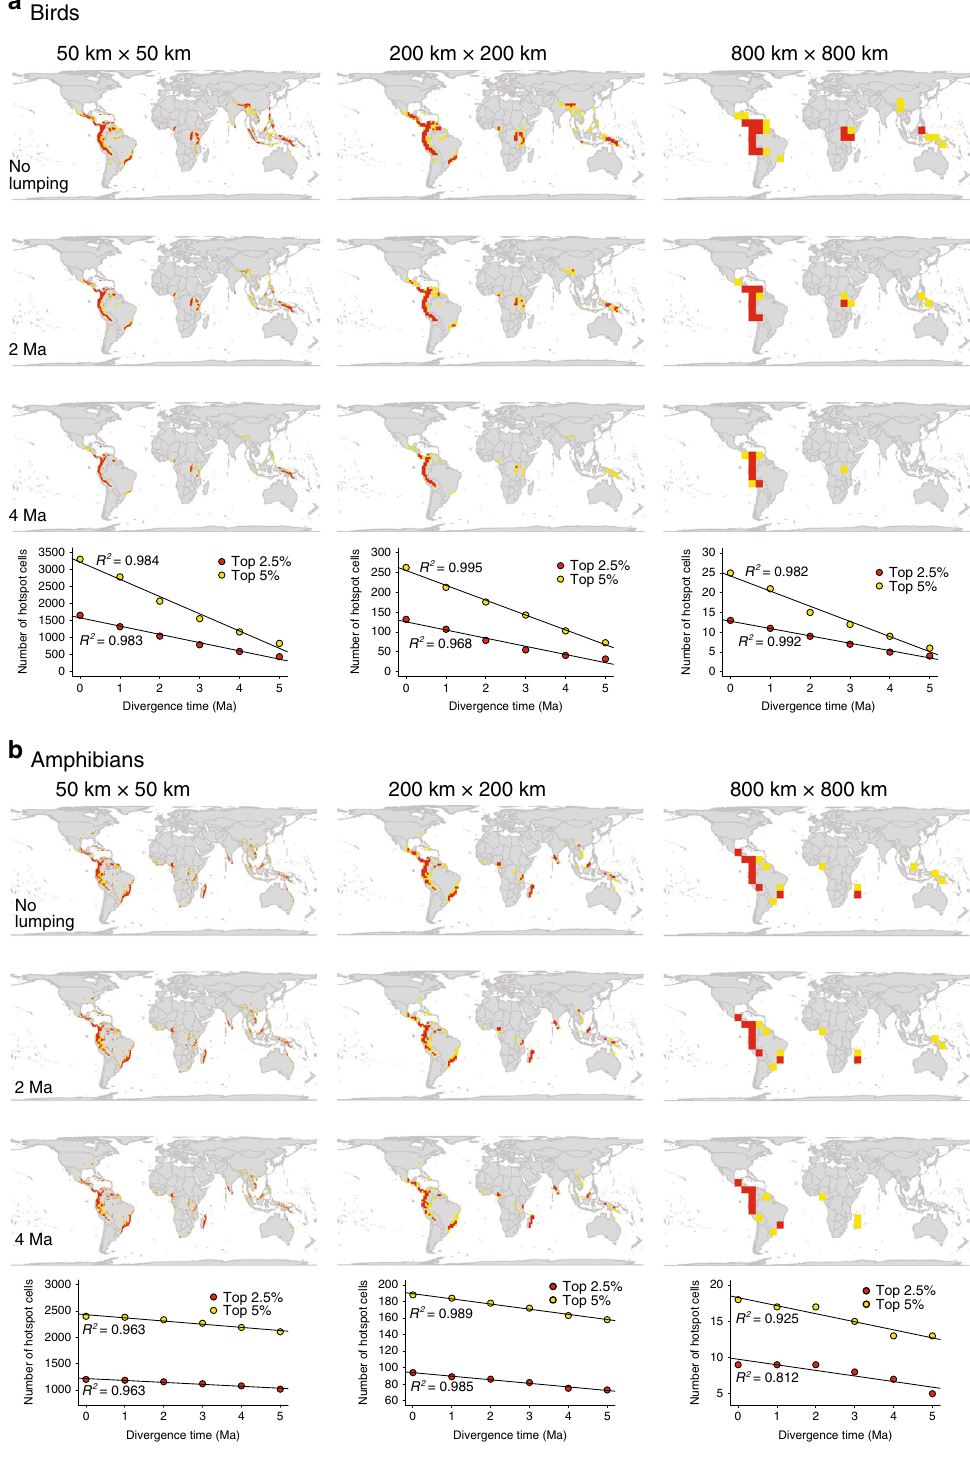
Fig. 2 Scale-dependent effects of spatial grain and taxonomic treatment on hotspots of weighted endemism, calculated by weighting species according to their range sizes. a Birds ( n = 10,018 species), and b amphibians ( n = 5872 species). Hotspots were identi fi ed using the 2.5% threshold based on the 97.5th percentile values for weighted endemism per grid cell (indicated in red), and 5% corresponding to 95th percentile values (indicated in yellow). Variations of taxonomic treatments in presented results are based on species ’ divergence times at varying time depths: present-day, from 2 Ma, and from 4 Ma — replicating increasing ‘ lumping ’ of taxa. Scatterplots indicate that as taxonomic lumping increases with respect to phylogenetic divergence times, the number of hotspot cells successively decline for both birds ( a ) and amphibians ( b ). Analysis of clade collapse was based on a randomly selected subset of 100 trees from a posterior distribution of 600 trees for birds and 100 trees from a posterior distribution of 10,000 trees for amphibians. The maps are in Behrmann projection. See Supplementary Fig. 2 for the full variation of weighted endemism across grid cells at 50, 100, 200, 400 and 800 km and at varying taxonomic treatment based on species ’ divergence times from 1, 2, 3, 4 and 5 Ma. Source data are provided as a Source Data fi